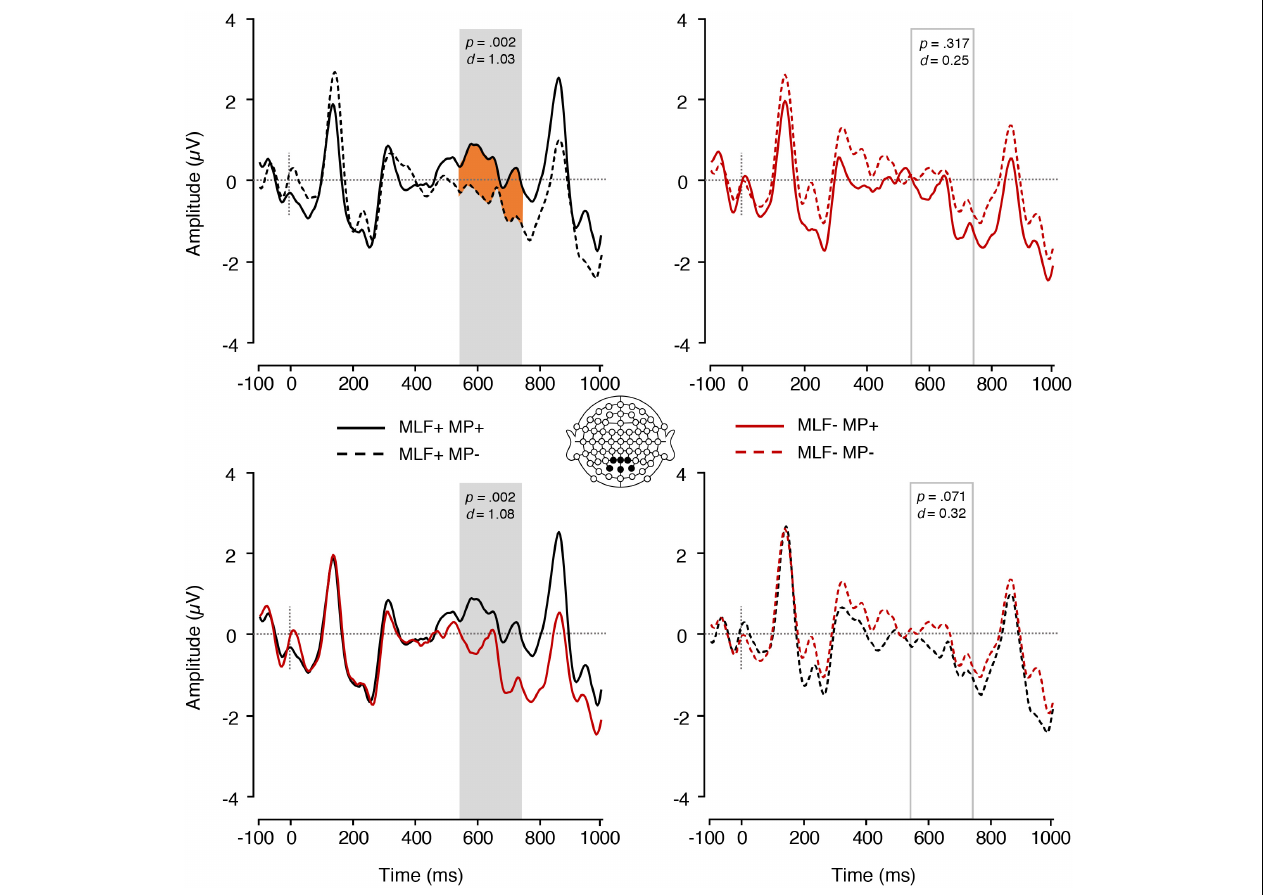
FIGURE 4 | ERPs elicited by nouns preceded by adjectives depicting the interaction between MLF and MP. The plain grey box indicates the time window of the analysis in which mean ERP amplitudes significantly differed between conditions (550–750 ms post-stimulus). MLF, Matrix Language Framework; MP, Minimal Programme; +, stimuli compliant with prediction; –, stimulus violating prediction.